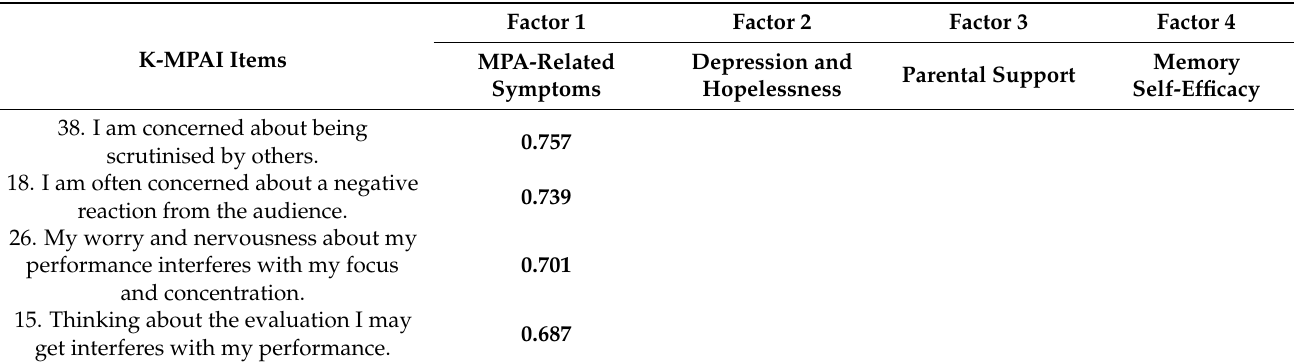
Table 2. Results of exploratory factor analysis for the K-MPAI and factor loadings of the 30 items (final